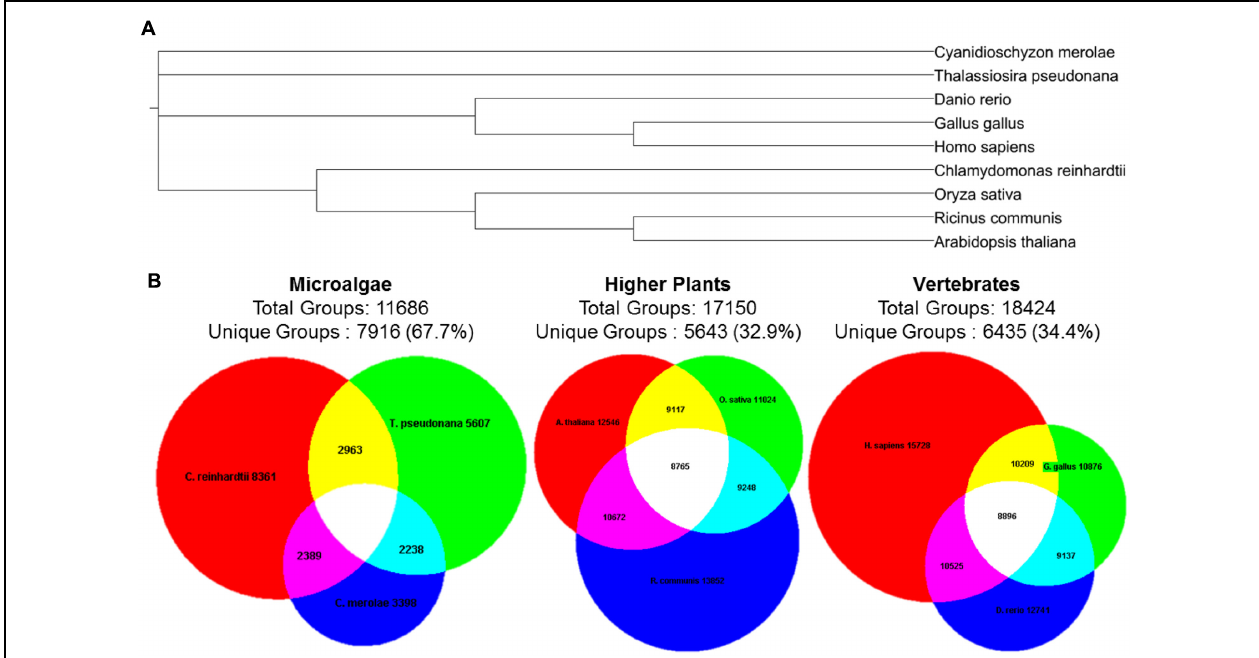
FIGURE 1 | Diversity of protein ortholog groups in microalgae, higher plants, and vertebrates. (A) Phylogenetic tree of the selected species according to NCBI taxonomy. The tree was constructed using PhyloT and iTOL (Letunic and Bork, 2011). (B) Unique and shared groups of protein orthologs according to OrthoMCL database (Chen et al., 2006). The Venn diagrams were constructed using Euler3Applet (Chow and Rodgers, 2005). Common names for the species: Chlamydomonas reinhardtii (green alga, red circle); Thalassiosira pseudonana (diatom, green circle) Cyanidioschyzon merolae (red alga, blue circle); Arabidopsis thaliana (thale cress, red circle); Oryza sativa (rice, green circle); Ricinus communis (castor oil plant, blue circle); Homo sapiens (human, red circle); Gallus gallus (chicken, green circle); Danio rerio (zebrafish, blue